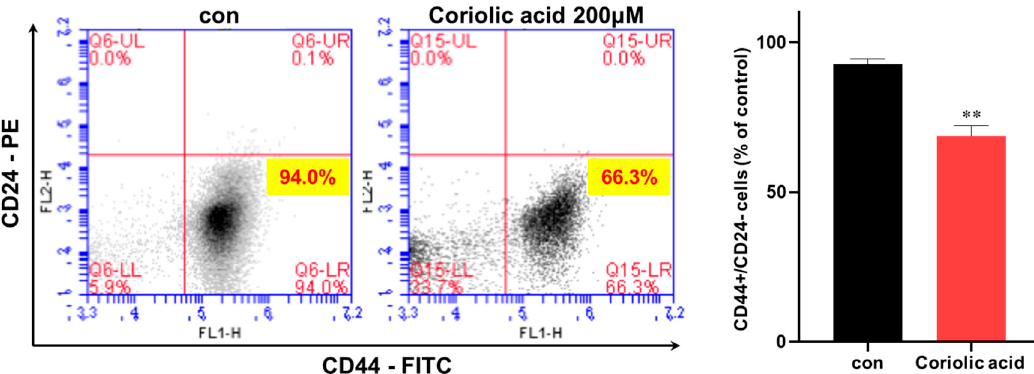
Figure 4. The effects of coriolic acid on the CD44 high /CD24 low -expressing cells within an MDA-MB-231 cell population. The CD44 high /CD24 low subpopulation treated with/without coriolic acid (200 µM) for 1 day was tested by flow cytometry. For this analysis, 2 × 10 4 cells were utilized. The red cross was based on the binding of an antibody without coriolic acid. The data are represented as the mean ± SD; ** p < 0.01.